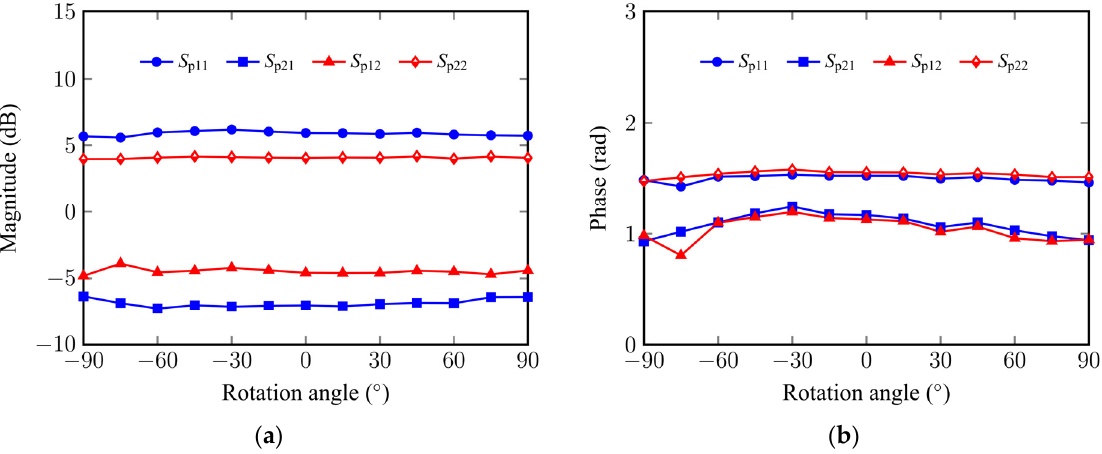
Figure 14. Measured results of the transfer responses for virtual plants and the transfer responses between the virtual microphone locations and the physical microphone locations in the primary field with human head rotation: ( a ) magnitude; ( b ) phase.